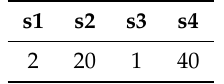
Table 2. Emulated packet-loss percentages for